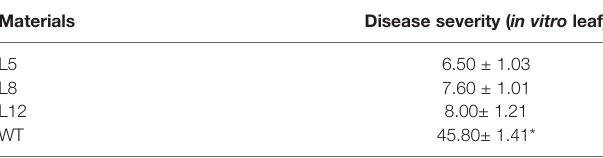
Data are mean values ( ± SD) of three independent experiments. *indicates signi fi cantly different values between treatments (p < 0.05). L5, L8, and L12 are three independent transgenic lines that overexpress